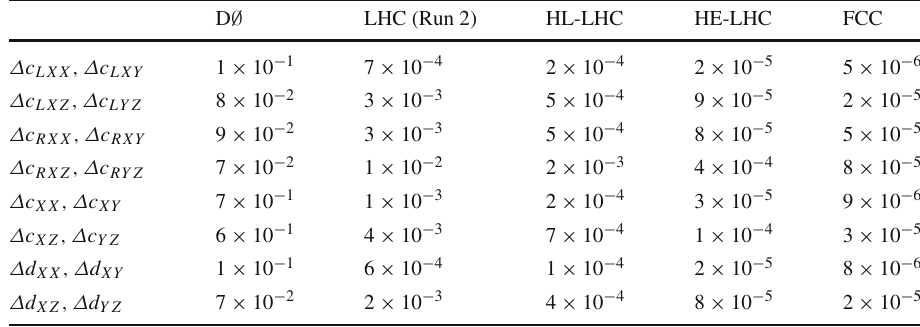
Table 1 Comparison of expected precision in the measurement of the SME parameters, extrapolated from t ¯ t measurements [11,18], for DØ, LHC Run 2, HL-LHC, HE-LHC, FCC